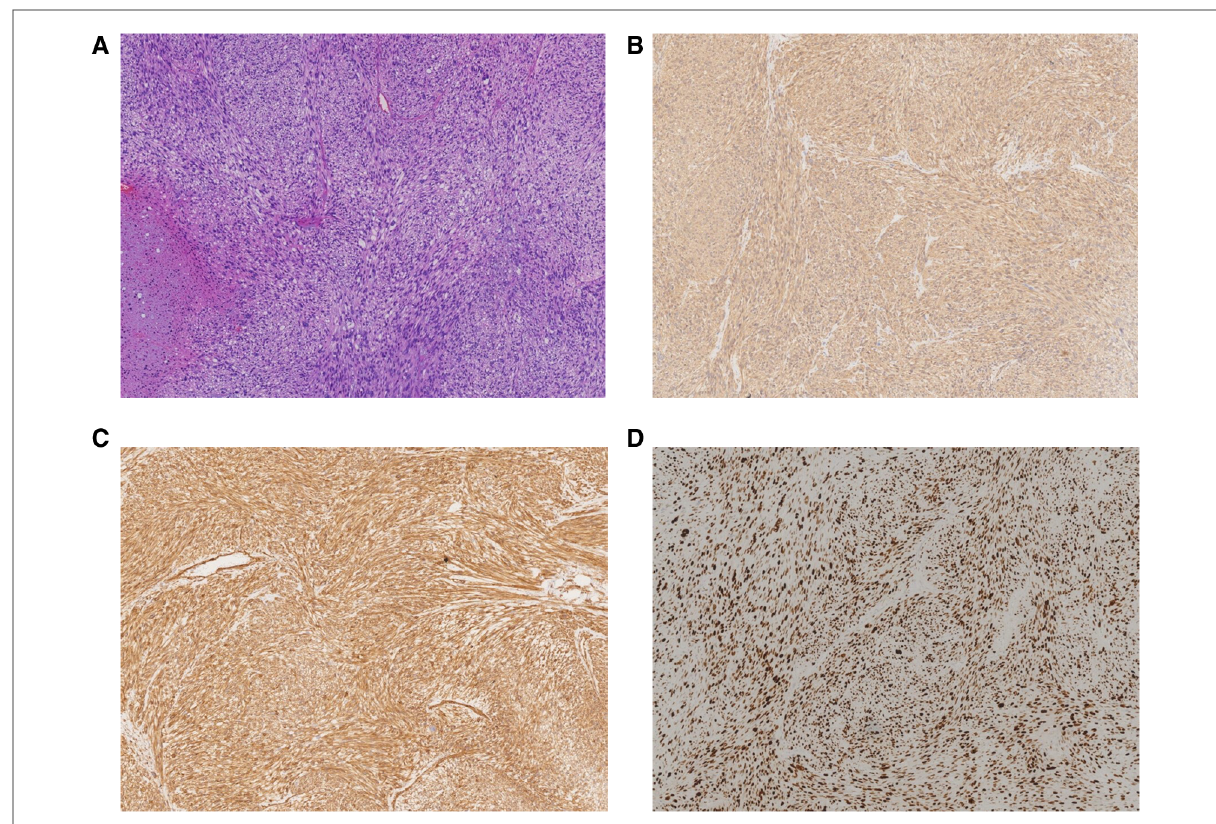
FIGURE 2 Pathological examination showing that the mass was composed of atypical spindle-shaped cells tumor with focal necrosis. ( A ) Hematoxylin and eosin (HE) staining with high mitoses and atypical mitoses (×40). ( B ) Immunohistochemistry staining of SMA (×40). ( C ) Immunohistochemistry staining of Caldesmon (×40). ( D ) Immunohistochemistry staining of Ki-67